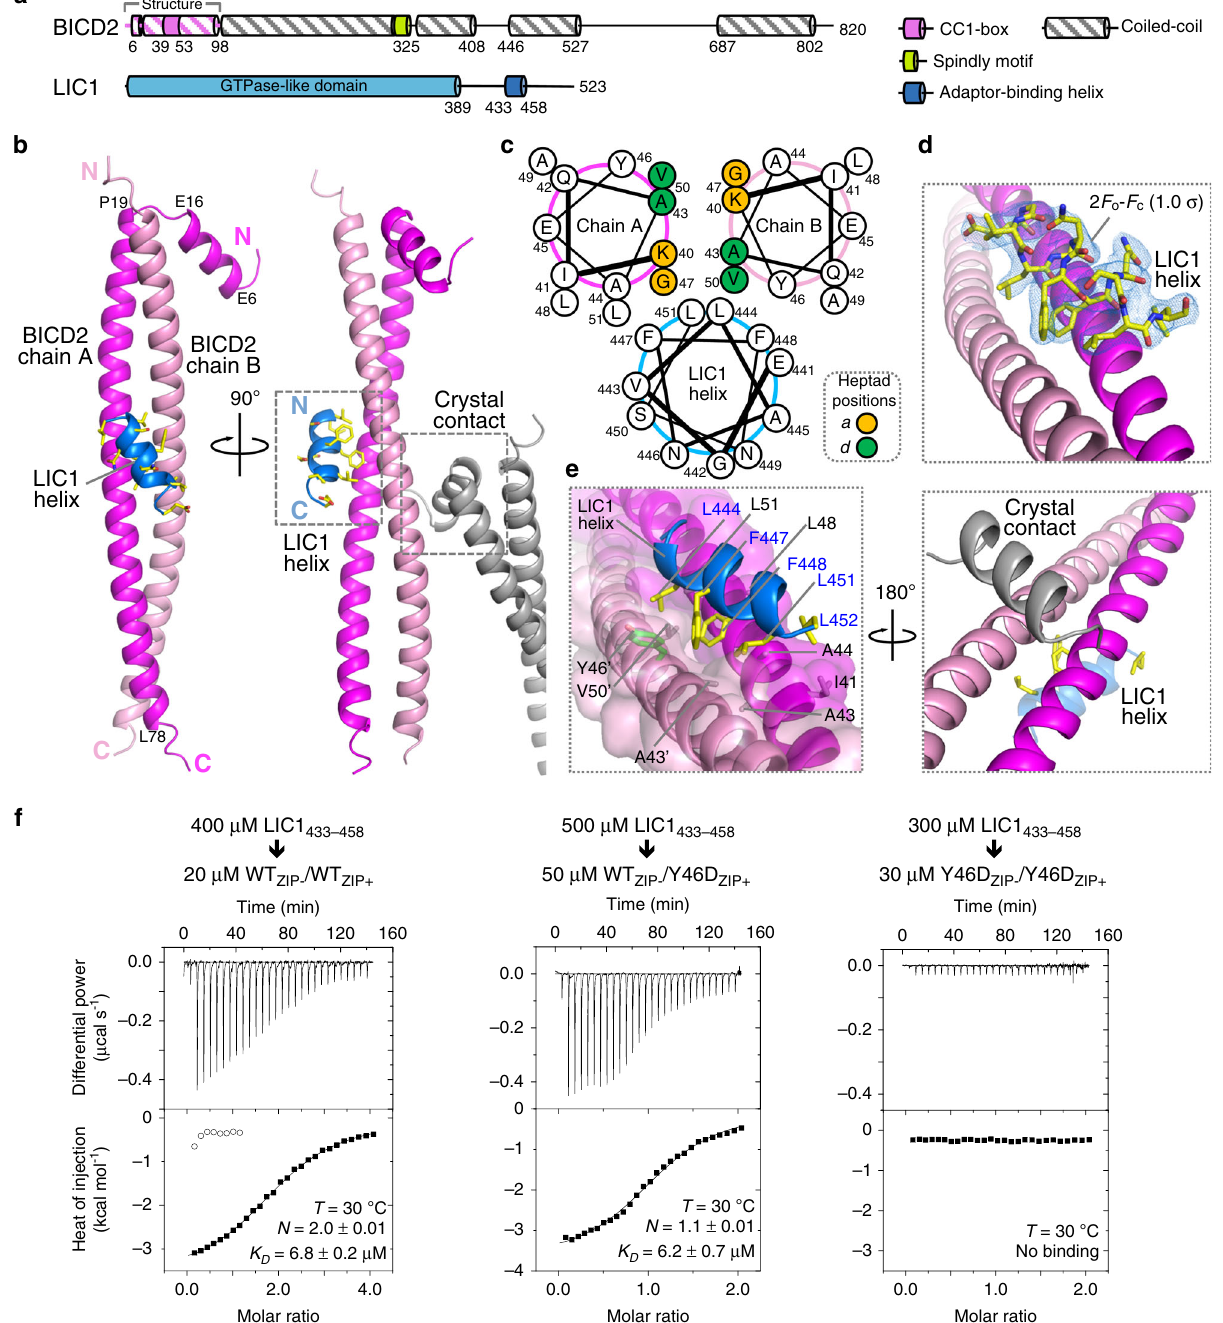
Fig. 1 LIC1 interaction with CC1-box-containing dynein – dynactin adaptors. a Domain organization of human LIC1 and BICD2, highlighting the BICD2 1 – 98 fragment containing the CC1-box that was co-crystallized with LIC1 433 – 458 . b Ribbon diagram showing two perpendicular views of the structure of the complex of BICD2 1 – 98 (coiled-coil chains A and B are colored magenta and pink, respectively) with LIC1 433 – 458 (blue). The side chains of LIC1 433 – 458 are shown using a stick representation and colored by atom type. A symmetry-related BICD2 1 – 98 molecule (gray) occludes the second LIC1 433 – 458 binding site. c Helical-wheel representation of the interaction of LIC1 433 – 458 with the CC1-box motif of BICD2. d , e Close-up views showing the interactions of LIC1 433 – 458 and a symmetry-related molecule on opposite sides of the BICD2 coiled-coil. The 2Fo – Fc electron density map (blue mesh) contoured at 1.0 σ is shown around an all-atom representation of the LIC1 helix. Note that residues on the hydrophobic face of the LIC1 helix insert into a hydrophobic pocket formed at the interface of the two BICD2 chains. BICD2 residue Y46, which was mutated in this study, is shown in green. f ITC titrations of LIC1 433 – 458 into the indicated heterodimers of WT and mutant Y46D BICD2 obtained by fusing a ZIP + /ZIP − leucine zipper C-terminally to the BICD2 constructs (see also Supplementary Fig. 1). ITC data shown are representative of n = 3 independent experiments, with similar results. Listed for each titration are the experimental conditions and fi tting parameters, including the dissociation constant ( K D ) and binding stoichiometry ( N ) derived from fi tting to a binding isotherm (black line). Open symbols correspond to a control titration into buffer, shown for the fi rst eight injections of the fi rst experiment, since all the proteins were dialyzed in parallel. The K D and N values are given as mean ± s.d. of the fi